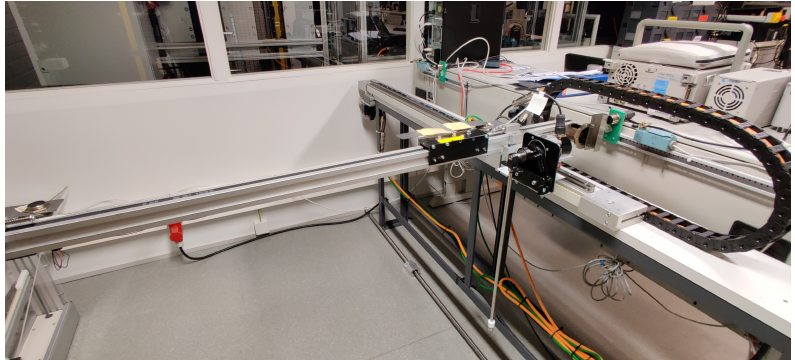
Figure 8. Experimental test setup emulating the trolley movement of the tower